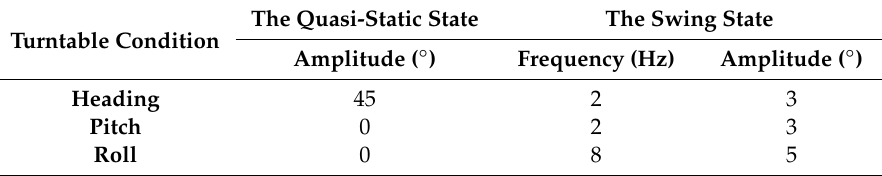
Figure 11. The position error of single-axis RINS in the quasi-static state.